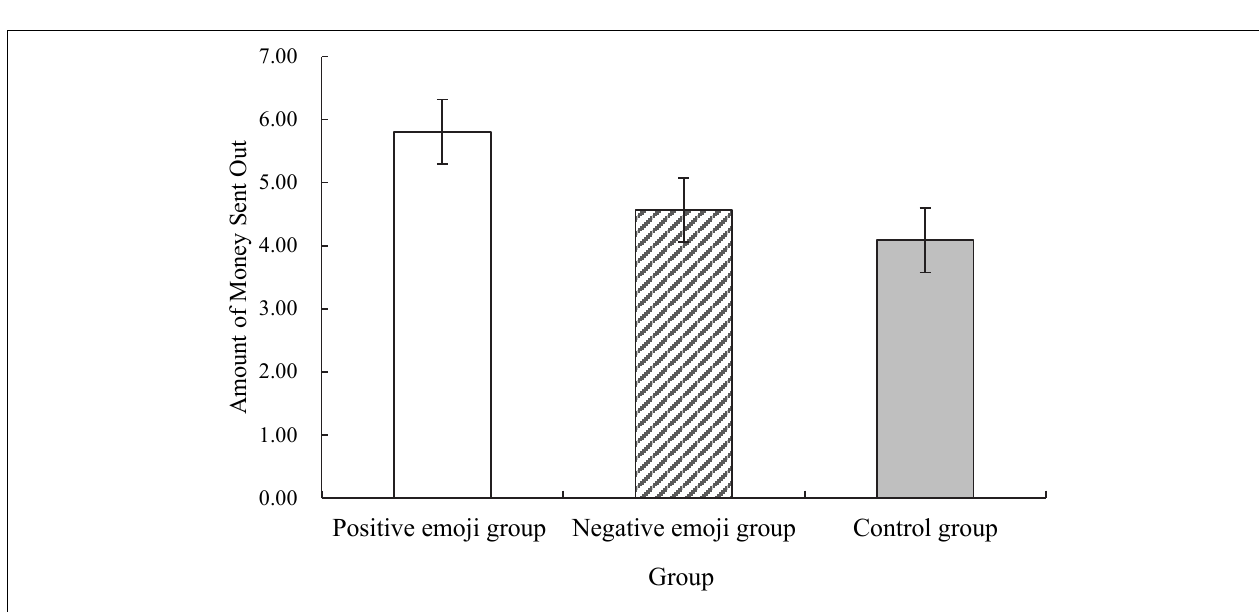
FIGURE 3 | Differences between the amount of money sent by the negative emoji group and the control group.